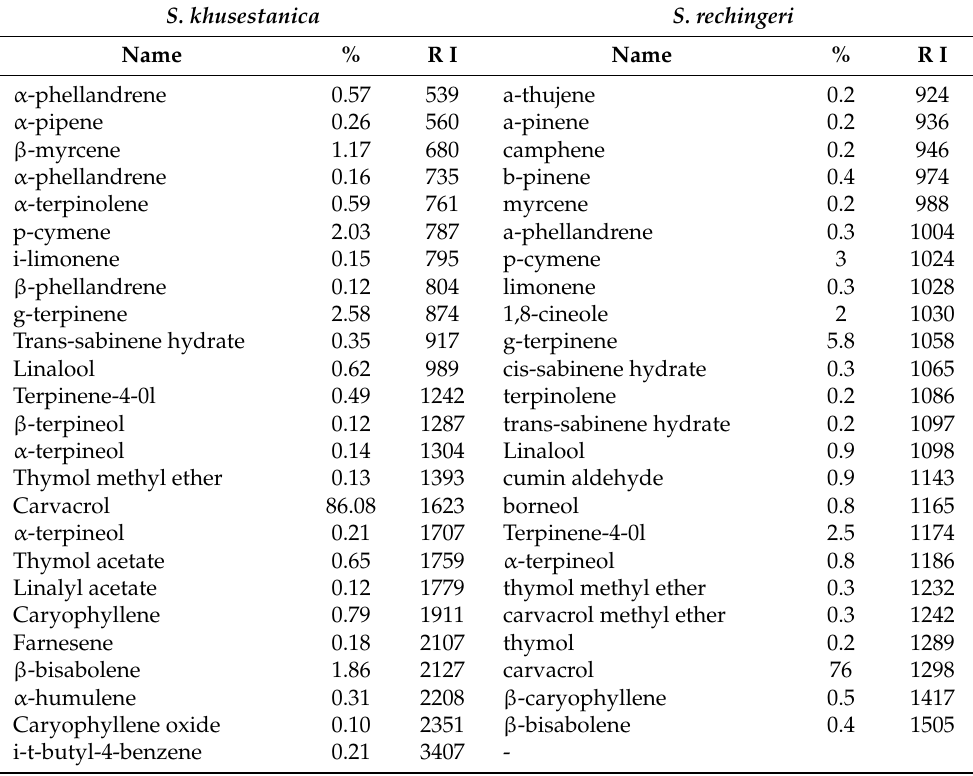
Table 8. Essential oil compounds two species of